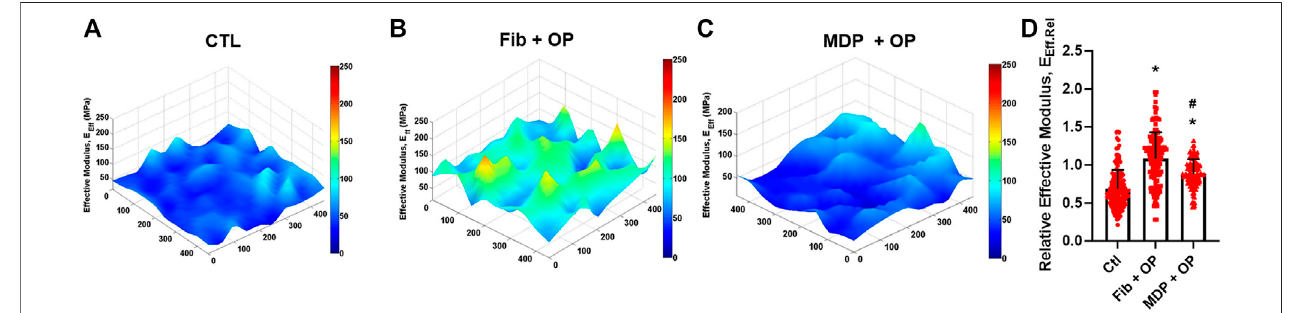
FIGURE 4 | Modulus mapping by nanoindentation of tendon sections (A – C) , showing more homogenous distribution of indentation moduli with MDP + OP as comparedtoFib+OP.Relativeeffectivemodulus(E Eff .Rel)athealingzoneinrespecttocorrespondingintactarea (D) weresigni fi cantlyhigherinFib+OPandMDP+OP thancontrol.E Eff .RelshowedlargervarianceinFib+OPthanMDP+OP(n=100 – 150pergroup;*: p < 0.0001comparedtocontrol;#: p < 0.0001comparedtoFib+OP). Effect of Oxo-M and 4-PPBP on macrophage